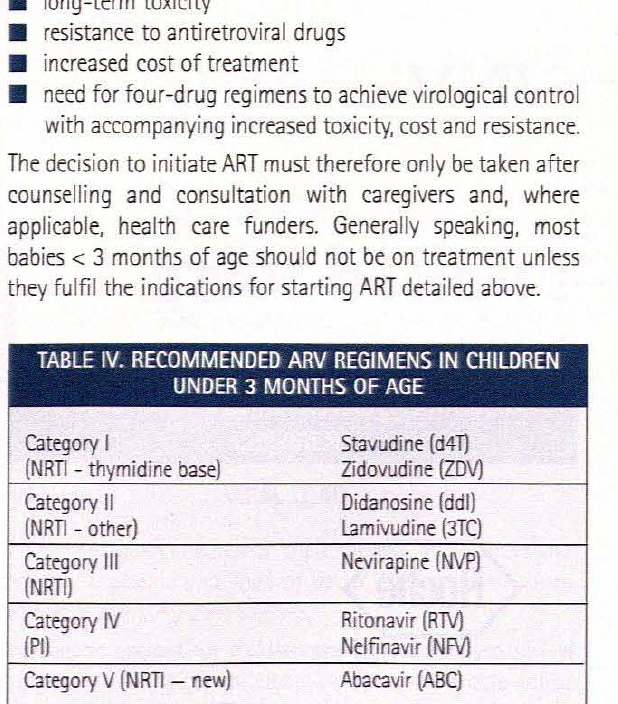
TABLE IV. RECOMMENDED ARV REGIMENS IN